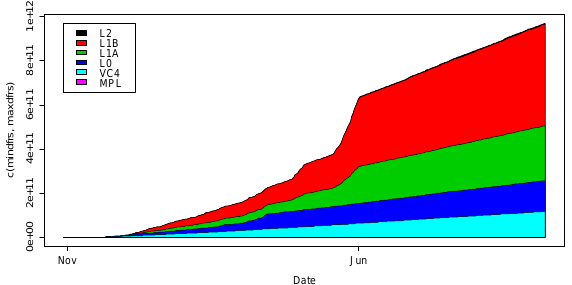
Figure 7: Archived Data Content per Level and Data